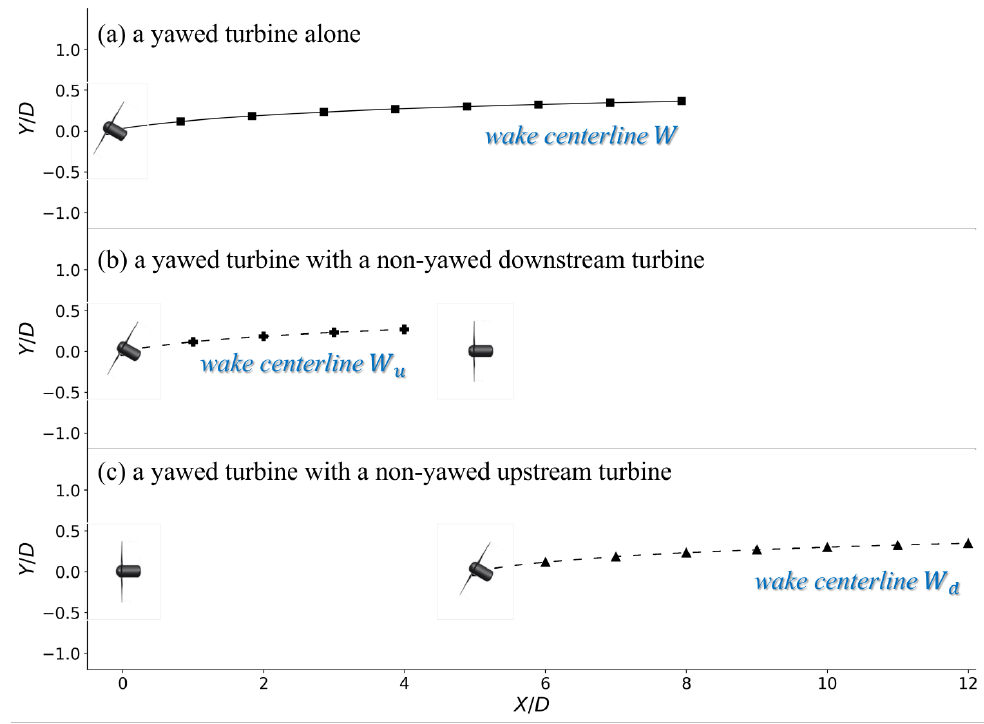
Figure 11. The definition of three types of wake centerlines for yawed